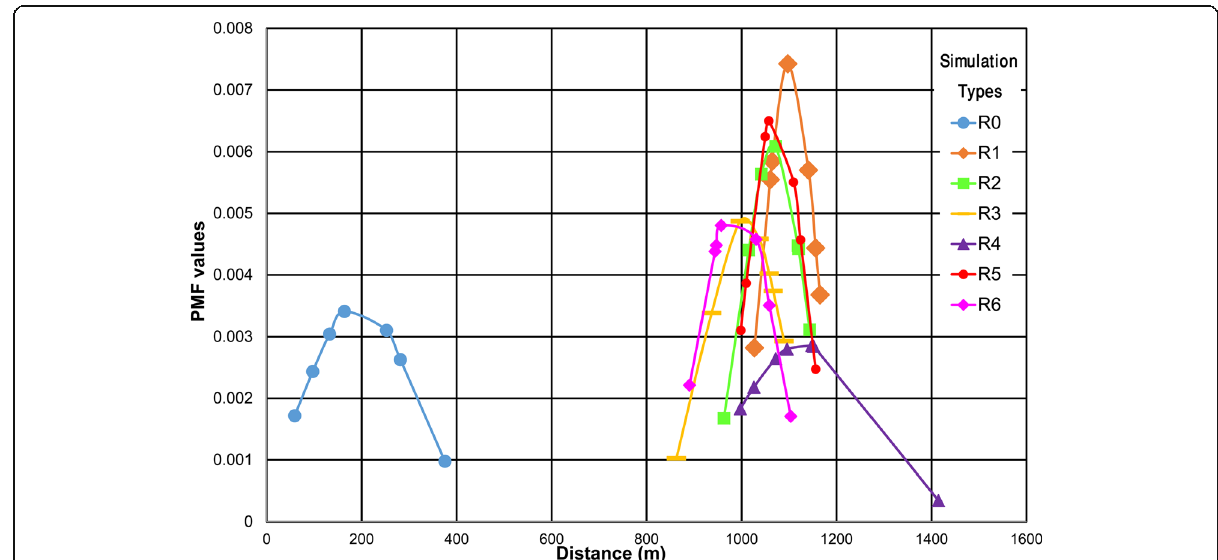
Fig. 11 Probability distribution chart of Plot